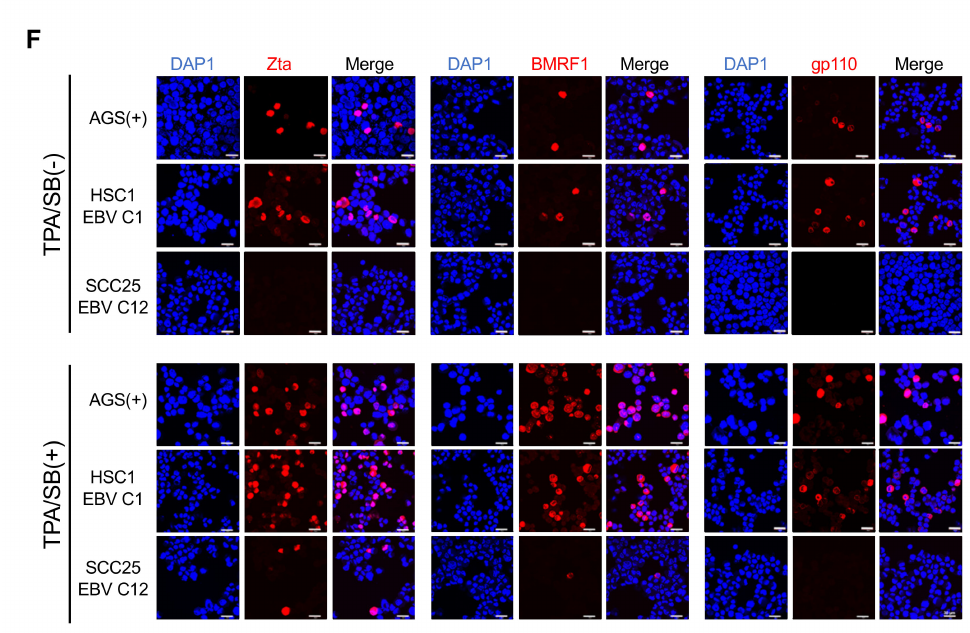
Figure 3. EBV spontaneously activates lytic replication in the di ff erentiated cells. The expression levels of lytic genes, including immediate early genes ( A ) BZLF1, BRLF1; early genes ( B ) BMRF1, and late genes ( C ) BALF4, BLLF1 were analyzed by qRT-PCR. EBV glycoprotein (gp350 / 220) positive cells were quantified by flow cytometry ( D ). The amount of virus produced from individual cells was calculated by flow cytometry ( E ). The expression of EBV lytic proteins, including Zta, BMRF1 and gp110, was examined by immunofluorescent staining ( F ). ***: p < 0.001. Scale bar: 30 µ m. 3.4. EBV Infection Promotes Cell Proliferation and Inhibits Programmed-Cell Death in SCC Cells.